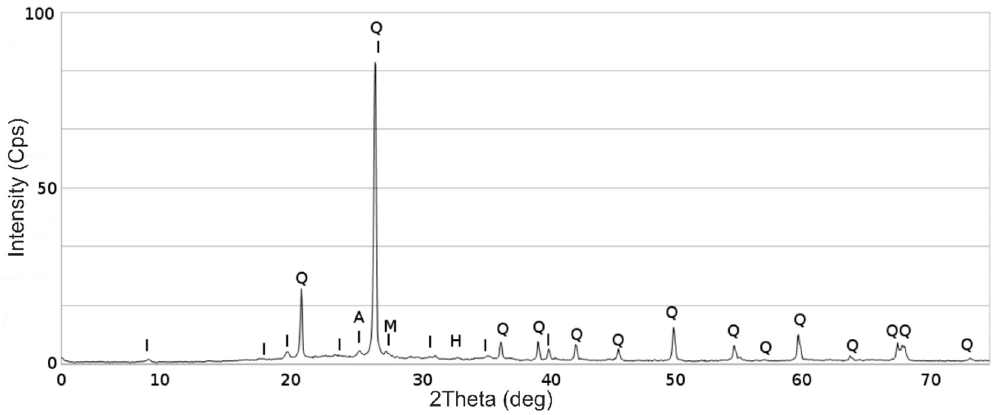
Figure 8. X-ray diffraction pattern of bottom ash from the combustion of coal from the Janina deposit, Q—quartz, I—illite, H—hematite, A—anhydrite, and M—microcline.